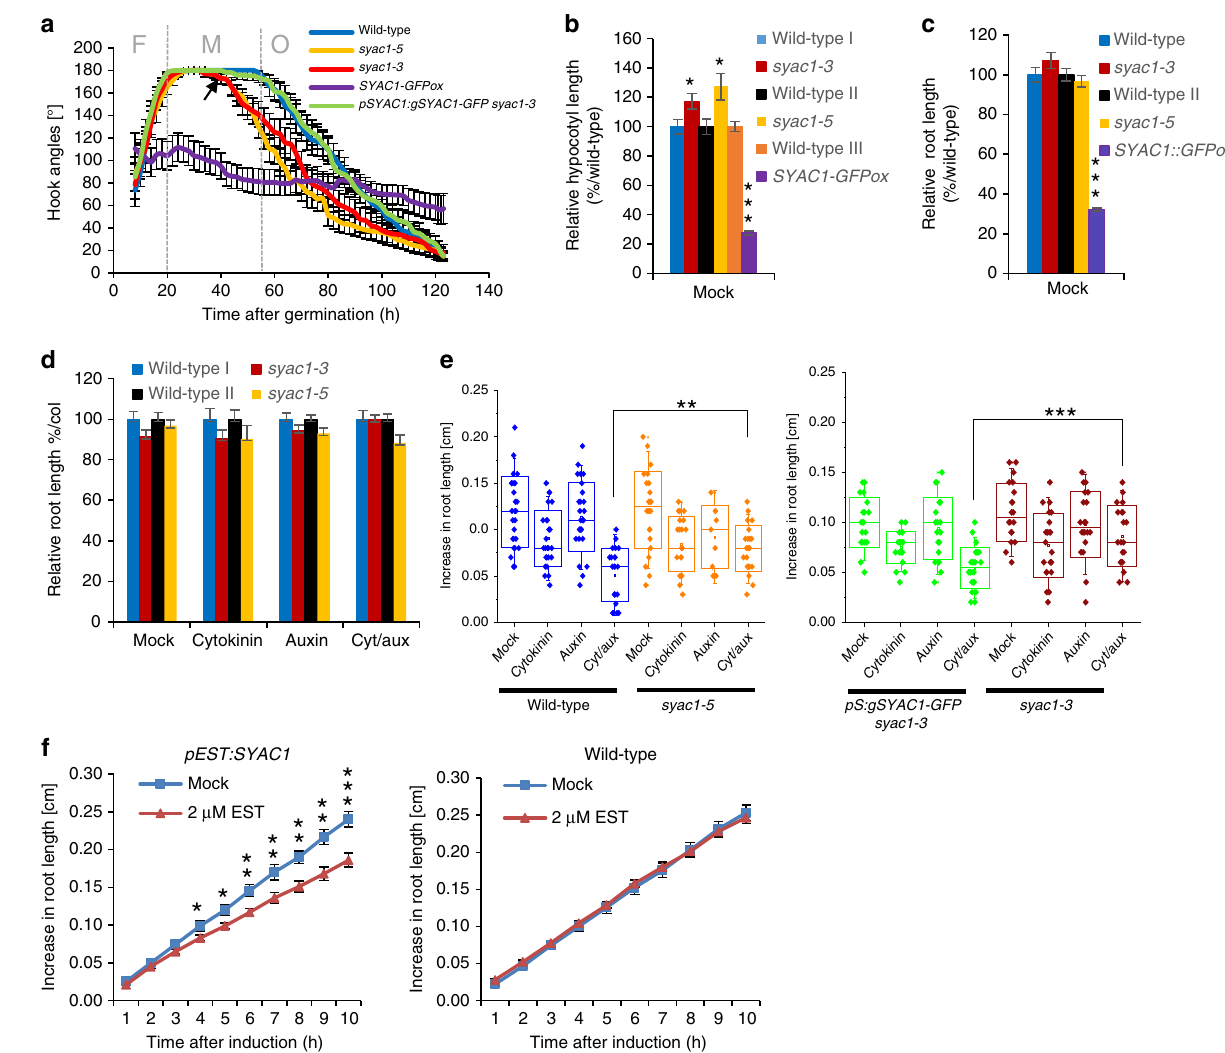
Fig. 2 Impact of modulated SYAC1 expression on seedling growth and sensitivity to plant hormones. a Real time monitoring of formation (F), maintenance (M), and opening (O) phase during apical hook development in wild type, syac1-3, syac1-5 , SYAC1ox overexpressor, and pSYAC1:gSYAC1-GFP syac1-3 seedlings . syac1-3 and syac1-5 exhibit premature transition from M to O phase when compared with wild-type control (black arrow indicates time of transition from M to O in syac1 ) and SYAC1ox fails to form an apical hook ( n = 9 – 11; average ± SE). Analyses of hypocotyl ( b ) and root ( c ) length in 4-day- old seedlings grown in darkness ( n = 14 – 20; ±SE) ( b ) and 5-day-old seedlings grown on the light ( n = 10; ±SE) ( c ). Analysis of root sensitivity to long-term ( d ) and transient ( e ) treatments with hormones. Wild-type and syac1 mutant seedlings were grown for 5 days on cytokinin (10 µ M), auxin (1 µ M), and on both hormones together ( n = 10; average ± SE) ( d ) or 5-day-old seedlings were transferred for 6 h on hormone free or with auxin (0.05 µ M), cytokinin (0.1 µ M), or auxin plus cytokinin supplemented media ( n = 10 – 20) ( e ). Wild type I and III represent respective control to syac1-3 and SYAC1-GFPox lines, respectively. Wild type II was isolated from syac1-5 heterozygote population ( b – e ). In the boxplots, center lines show the medians; box limits indicate the 25th and 75th percentiles as determined by Origin software; whiskers extend 1.5 times the interquartile range from the 25th and 75th percentiles, individual data points are represented by dots ( e ). f Transient induction of SYAC1 expression by estradiol (EST) triggers rapid deceleration of root growth. Five-day-old pEST:SYAC1 and wild-type seedlings transferred to mock or EST containing medium ( n = 9 – 10; average ± SE). Signi fi cant differences are indicated as * P < 0.05, ** P < 0.01, and *** P < 0.001 ( t -test) ( b – f ), compared with mock treated control ( b , c , f ) or to respective treatment of wild type ( d , e